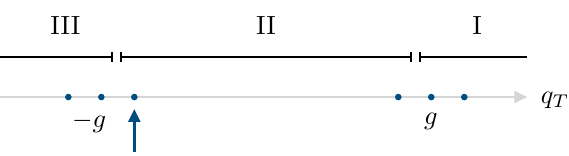
Figure 4 . We separate our discussion of the supersymmetric ground states for the XYZ model into three regions depending on the U(1) T (cid:13)avour symmetry charge q T . An arrow marks the point in region II where we obtain a complete